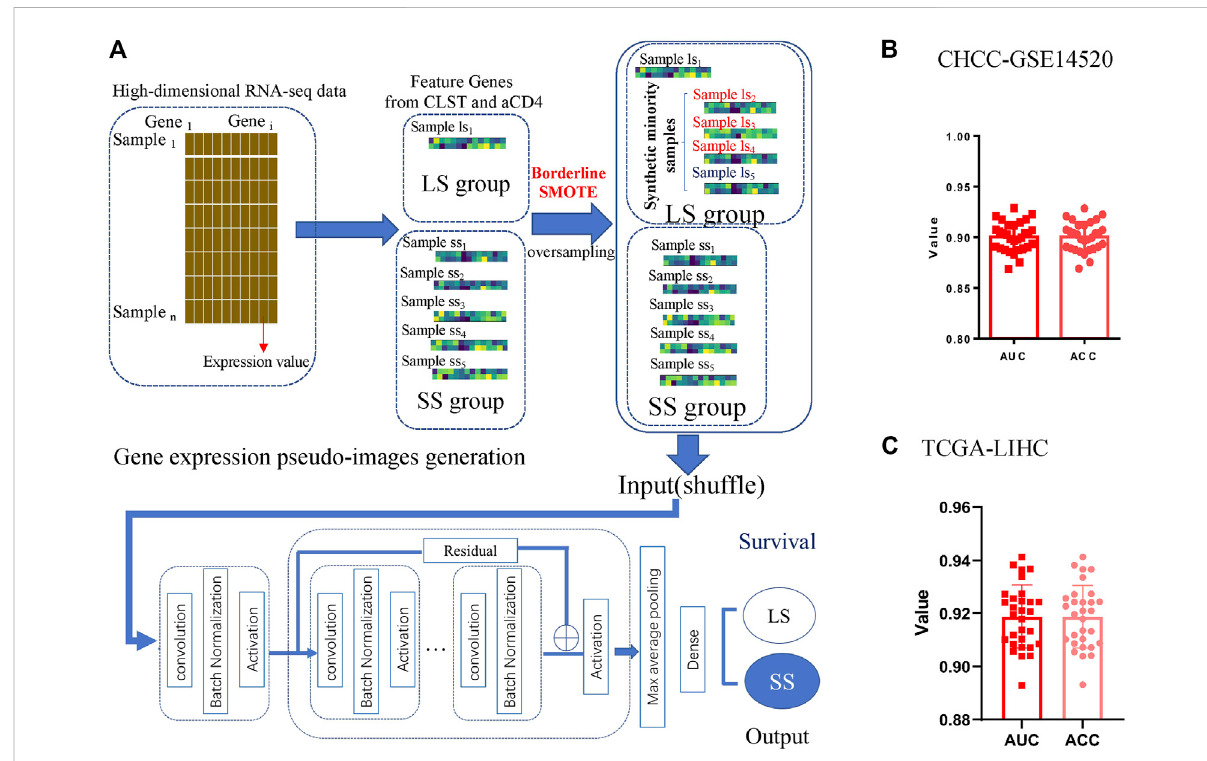
FIGURE 7 Unique feature genes belonging to CLST and aCD4 were promising prognostic signals in LS prediction. (A) Process of LS prediction in HCC patients (generation of gene expression pseudo-images with CLST and aCD4, oversampling with synthetic minority samples, input layer, detailed architectureofthedeepresidualnetworkmodule,andoutputlayerforLSstatusprediction). (B) TheaverageAUCandACCvaluesof30repeatsforLS status ( > 5 years) prediction in HBV-HCC patients. (C) The average AUC and ACC values of 30 repeats for LS status ( > 5 years) prediction in HCC